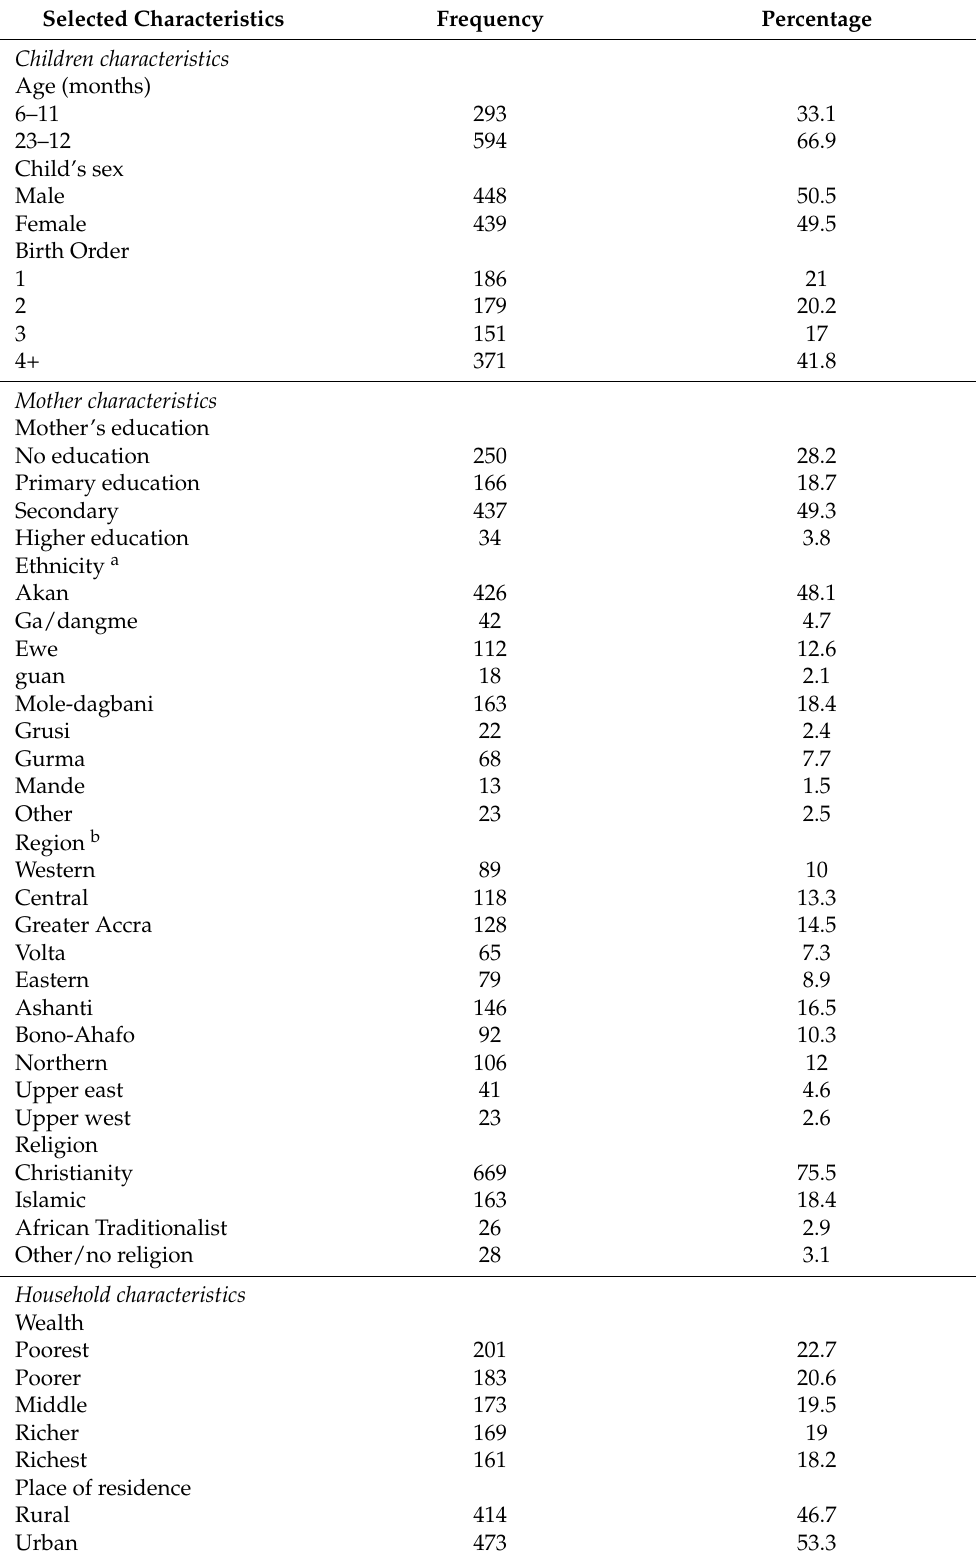
Table 2. Frequency and percentage of children by selected socio-demographic characteristics from the Ghana Demographic and Health Survey 2014 ( n =